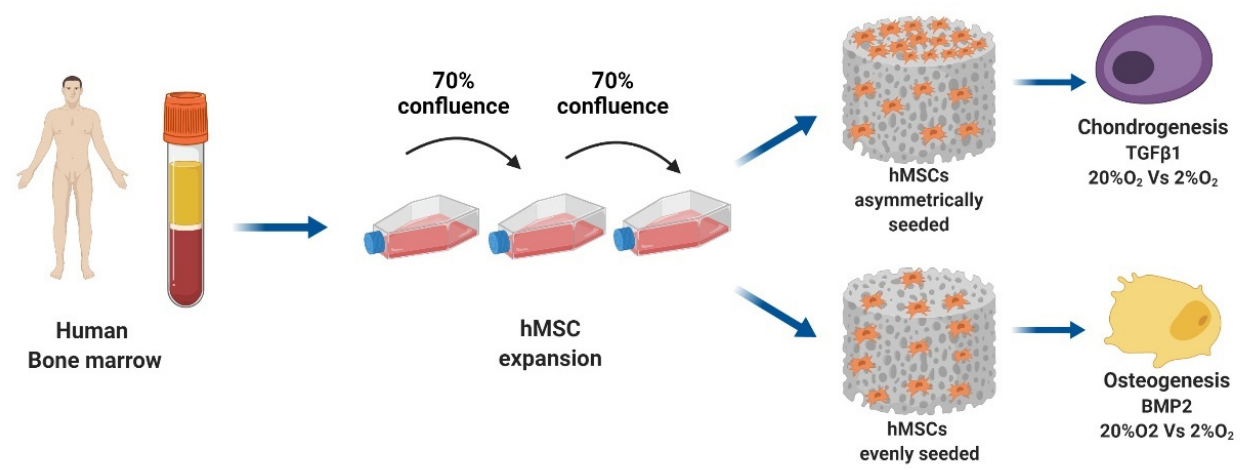
Figure 1. Schematic overview of the experimental design. Created with BioRender.com. 2.4. Gene Expression Analysis: RNA Isolation, cDNA Synthesis, Real Time qPCR After 14 days of culture, constructs were harvested and total RNA was isolated using TRI Reagent (Molecular Research Centre Inc, Cincinnati, OH, USA). Total RNA was iso- lated at day 0 to assess basal gene expression levels.